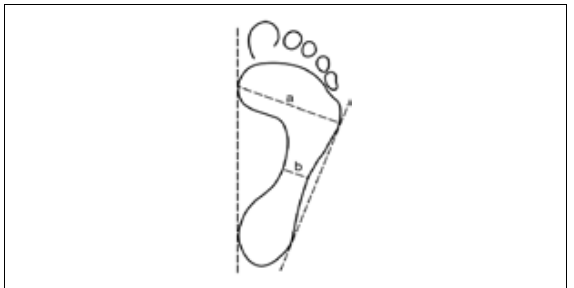
Figure 2. The Chipaux-Smirak Index (Onodera et al., 2008) The Staheli Index (SI) is the ratio between minimal width of the medial longitudinal arch area (b) and maximal width of the heel print (c). (c) is parallel to (b). SI = b/c. The MLA is classified as follows: ≤ 0.43 – high arch; 0.44 – 0.89 – normal; ≥ 0.90 – low (Staheli, 1997).